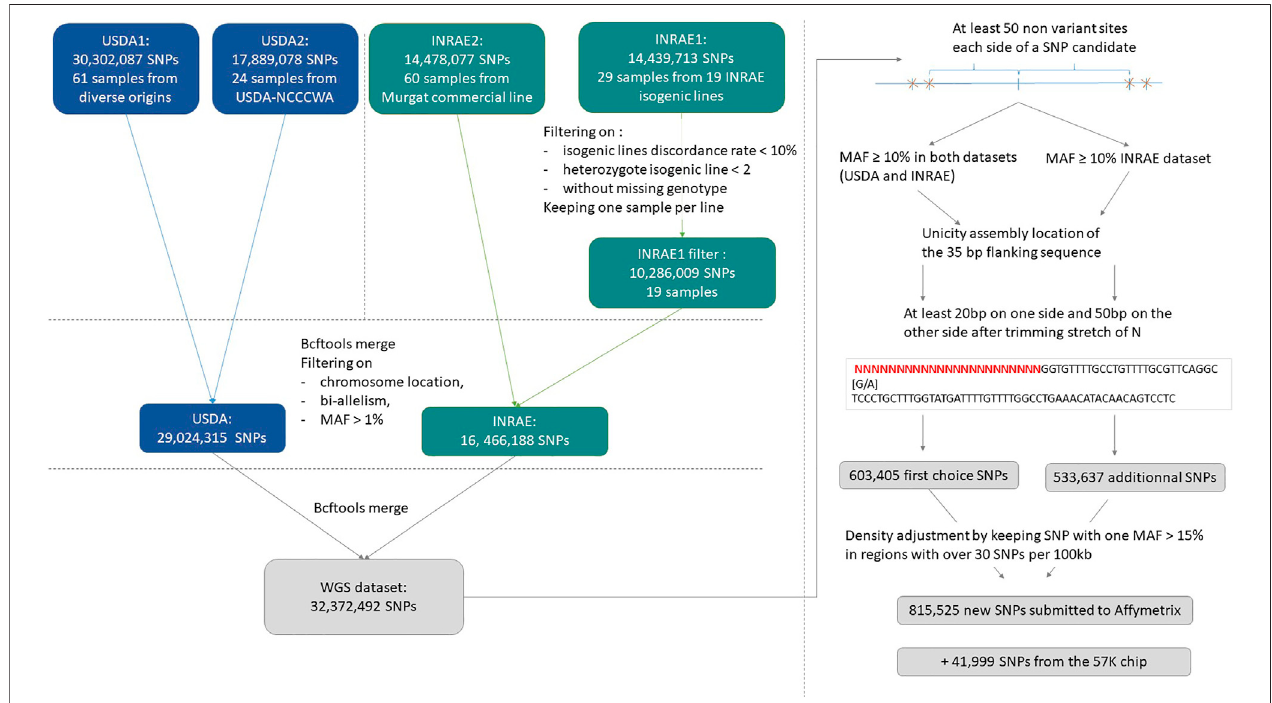
FIGURE 1 | Process for submitted SNPs for inclusion on a high-density genotyping array.